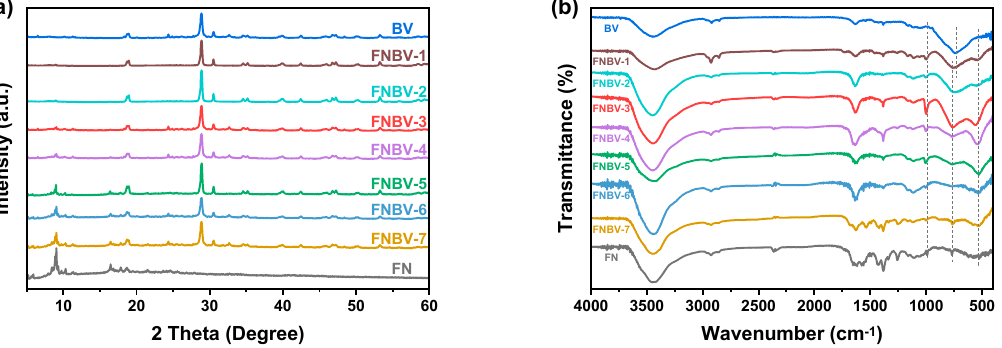
Figure 3. ( a ) XRD patterns of FN, BV, FNBV–n ( n = 1–7) samples; ( b ) FT–IR spectra of FN, BV, FNBV–n ( n = 1–7).